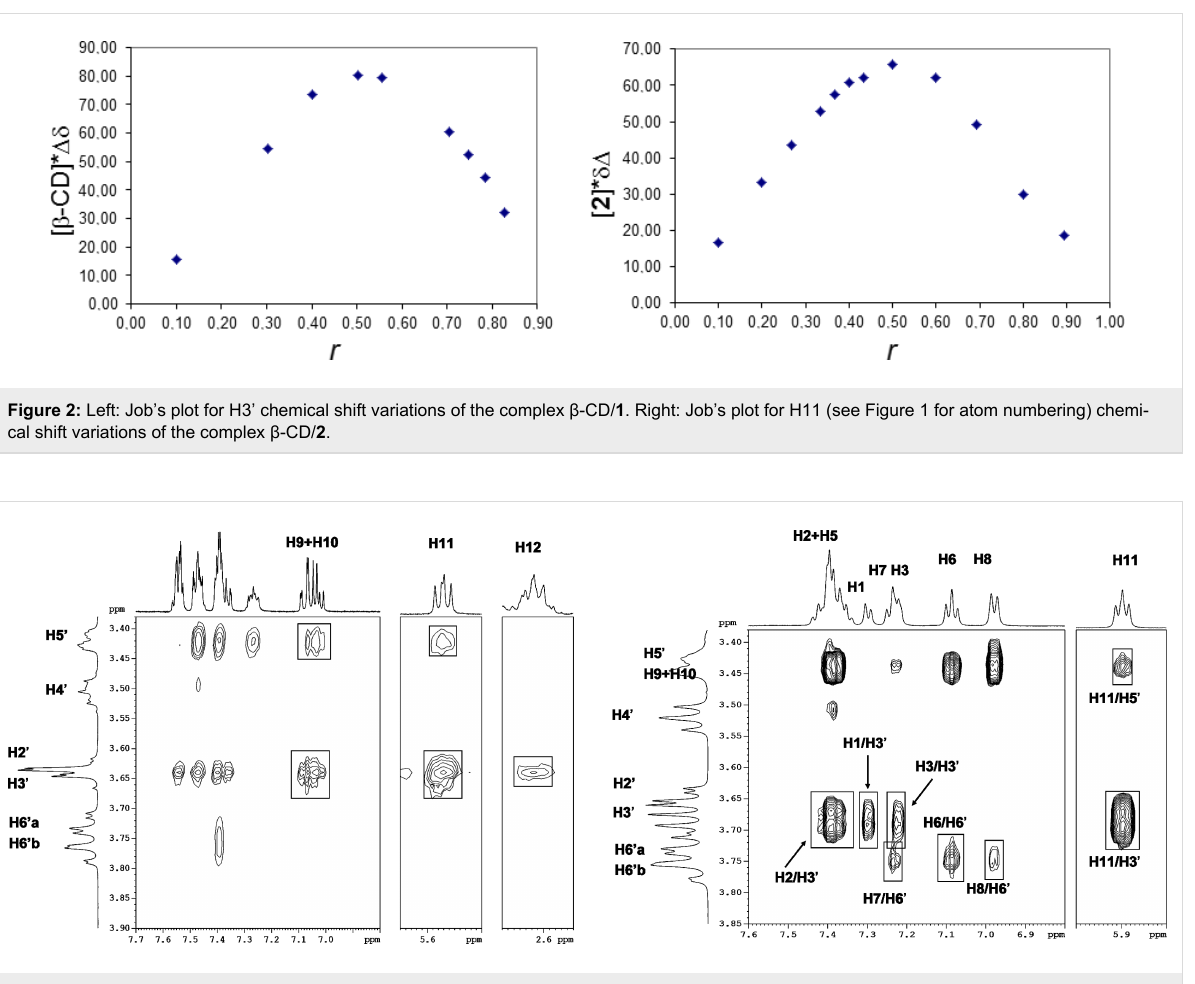
Figure 3: Expansion of 2D-ROESY of 1 / β -CD (left) and 2 / β -CD (right) complexes. Atom numbering is referred to Figure 1. Primed numbers are used for glucose units.